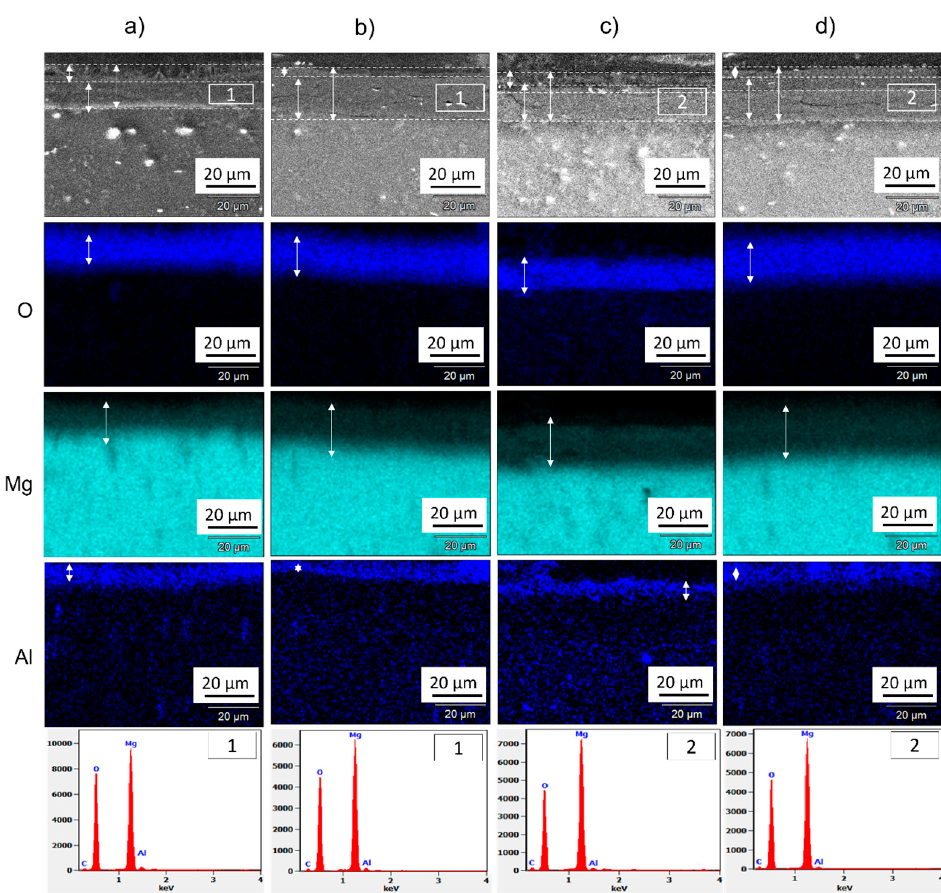
Figure 3. EDS mapping and EDS graphs of the cross-section of ( a ) E1024, ( b ) E1124, ( c ) A1024, and ( d ) A1124 (box 1 from the inner layer and box 2 from the inner and anodized layers).